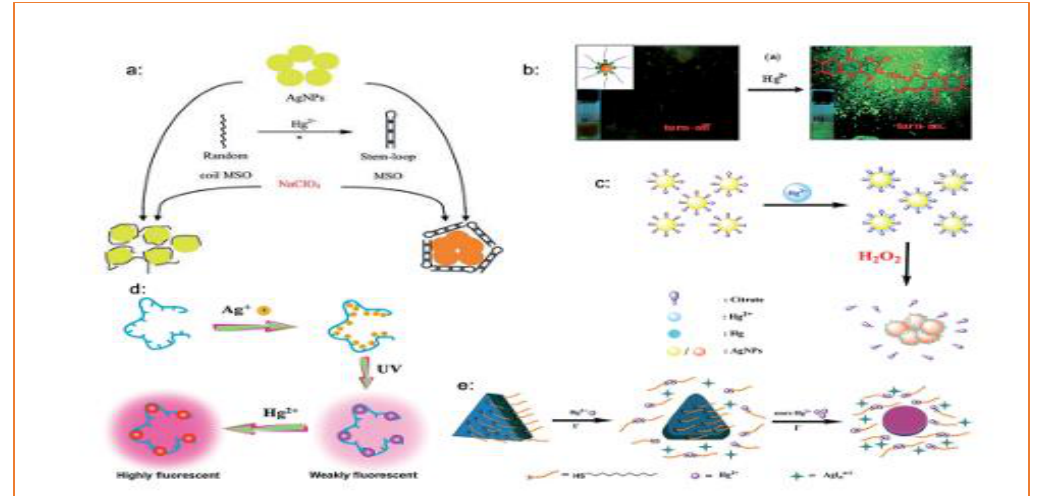
Fig. 16. Schematic strategies for the colorimetric sensing mechanism of AgNPs-based sensor for Hg 2+ . Reprinted with permission from ref.93. Copy right 2011 Royal Society of Chemistry. Table 2. List of ligands functionalized AuNPs and AgNPs with respect to their various